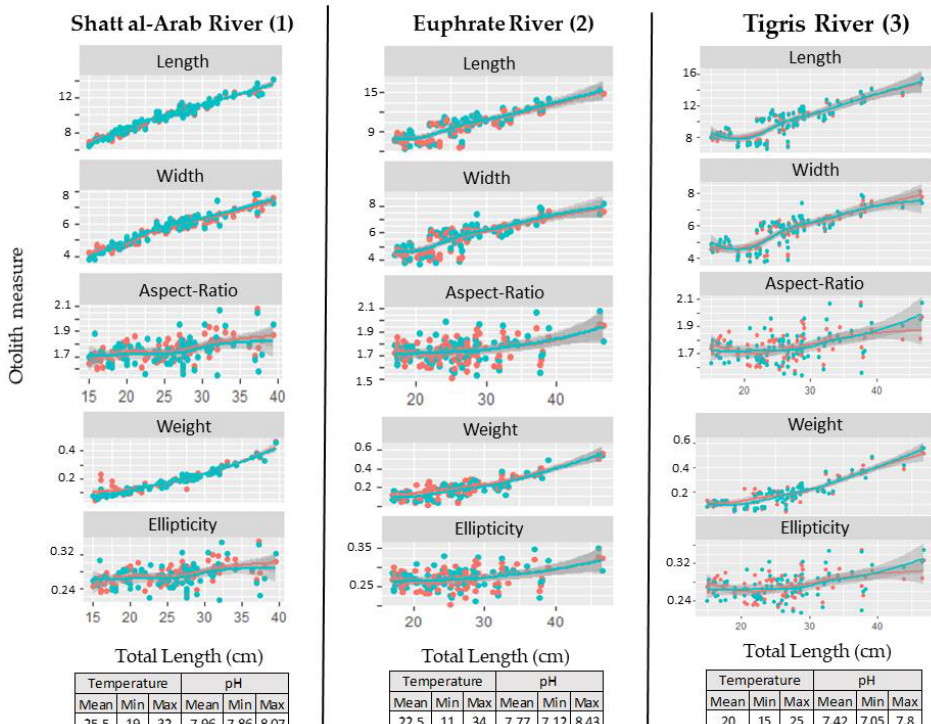
Figure 4. Relationships between fish length and asteriscii otolith morphological features (red points and line = left otolith, and green points and line = right otolith) according to the head side of Cyprinus carpio for each Iraqi River (for each river, the environmental data are presented).